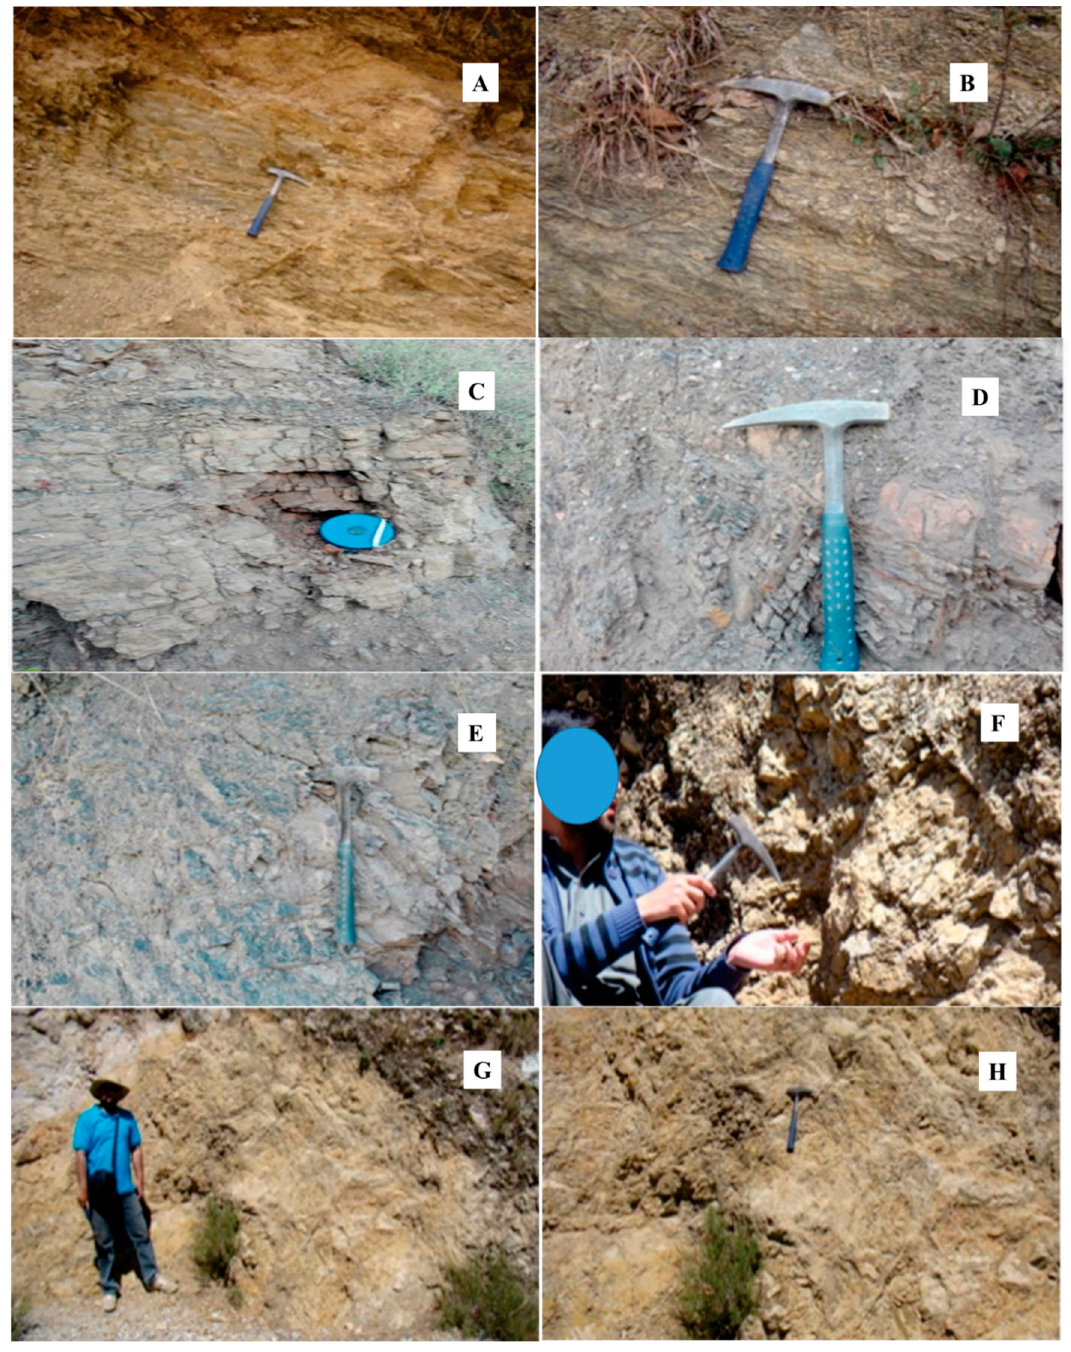
Figure 3. Field photographs of the Chichali Formation: ( A , B ) Yellowish brown to grey shales (Section 1), ( C – E ) organic-rich shales (Section 2), ( F – H ) light to dark brown shales with interbedded marl and sandstone (Section 3).